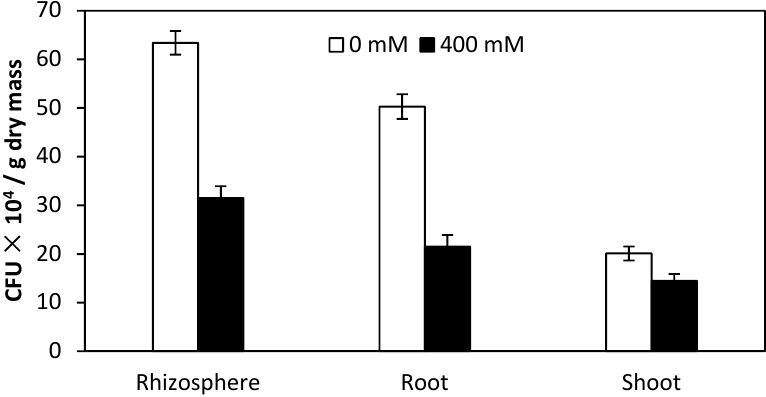
Figure 5. Colony-forming units (CFU) of Burkholderia phytofirmans PsJN in the rhizosphere, root and shoot interior of quinoa irrigated with 0 mM and 400 mM NaCl solution.